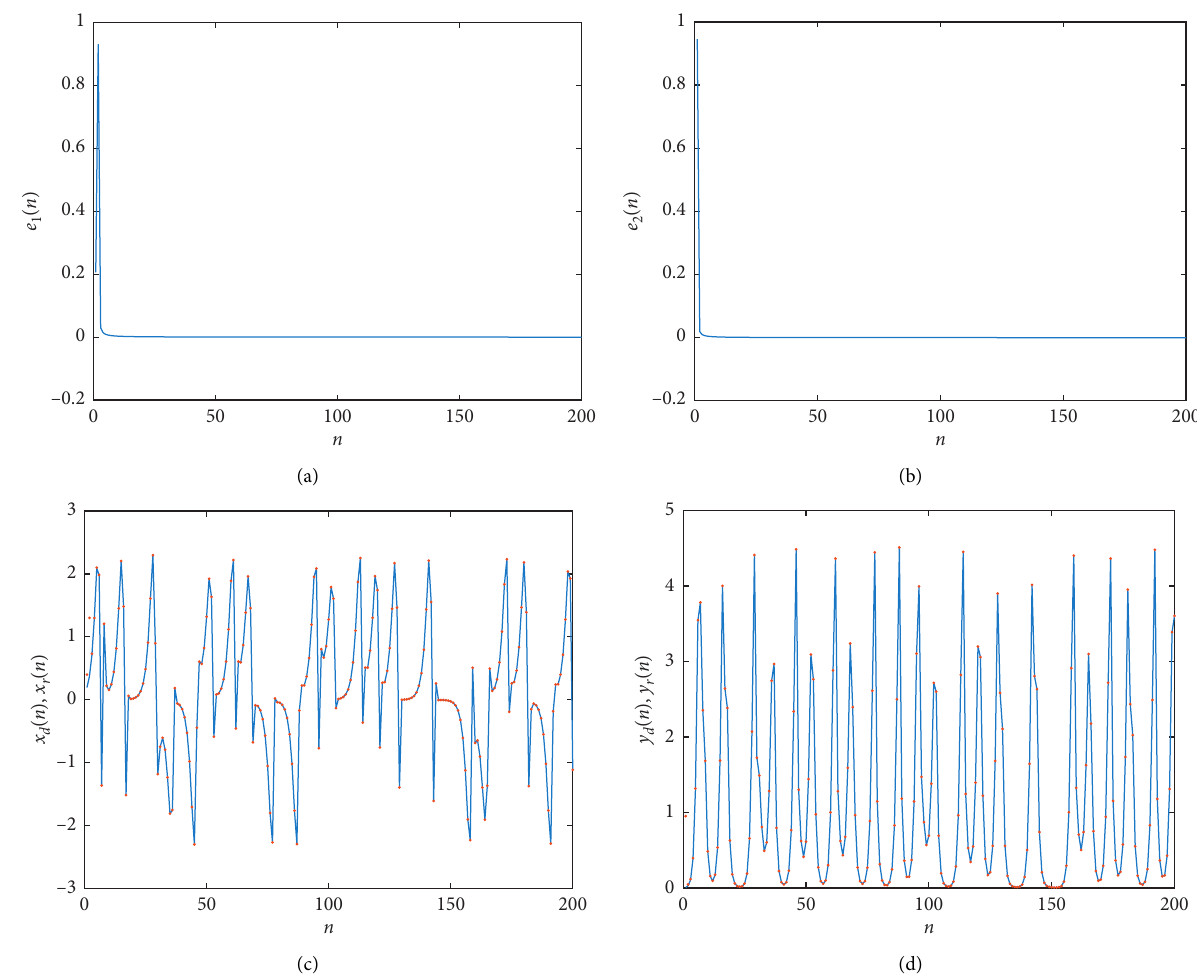
Figure 14: The simulation results for the synchronization of map (10): (a) the error state variable e ( n ) with the variation of n , (c) the state variables x state variable e 2 ( n ) and y ( n ) with the variation n y d r